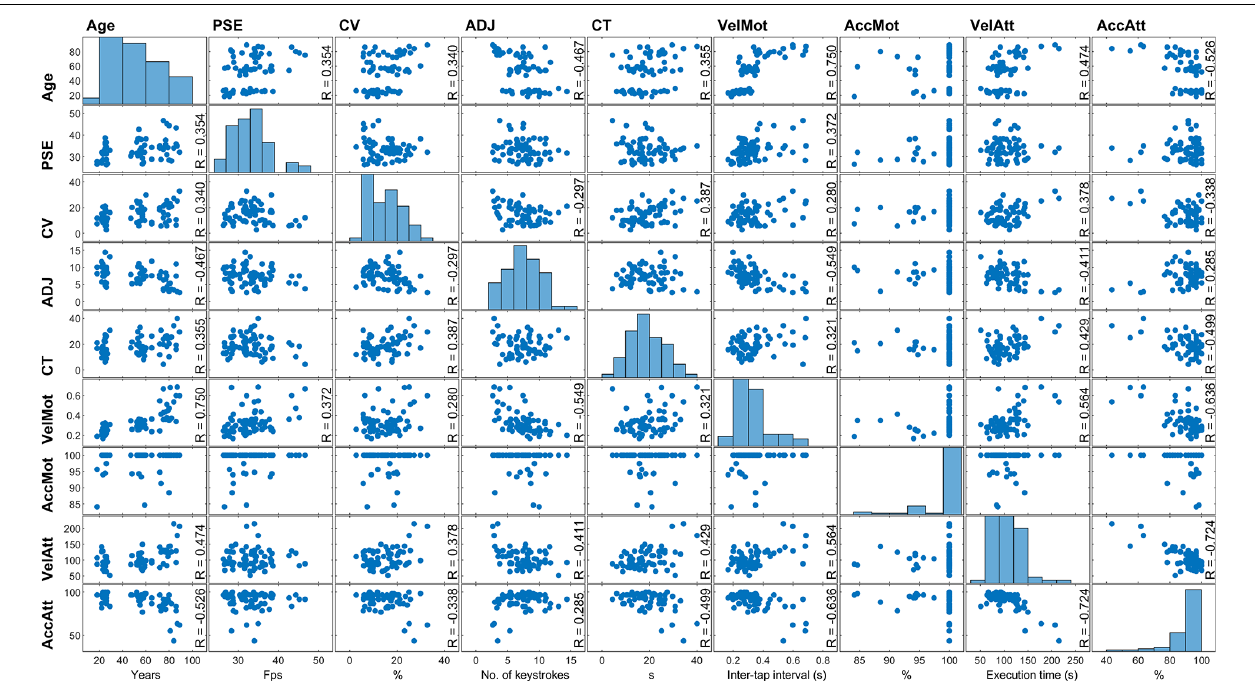
FIGURE 4 | Correlation matrix of the continuous variables considered in this study. Each data-point represents an individual participant. The plots along the diagonal report the frequency distributions. Note that information is repeated in the upper-right and lower-left halves of the figure, but with plots in each pair having inverted X-Y axes, which affords a more comprehensive data visualization. The zero-order correlation coefficient (R) is reported only when p < 0.05. PSE, Point of Subjective equivalence; CV, coefficient of variation; ADJ, adjustments; CT, completion time; VelMot, motor speed (speeded tapping); AccMot, motor accuracy (speeded tapping); VelAtt, attentional speed; AccAtt, attentional accuracy. Note that the values for motor and attentional speed represent in fact motor and attentional slowness.